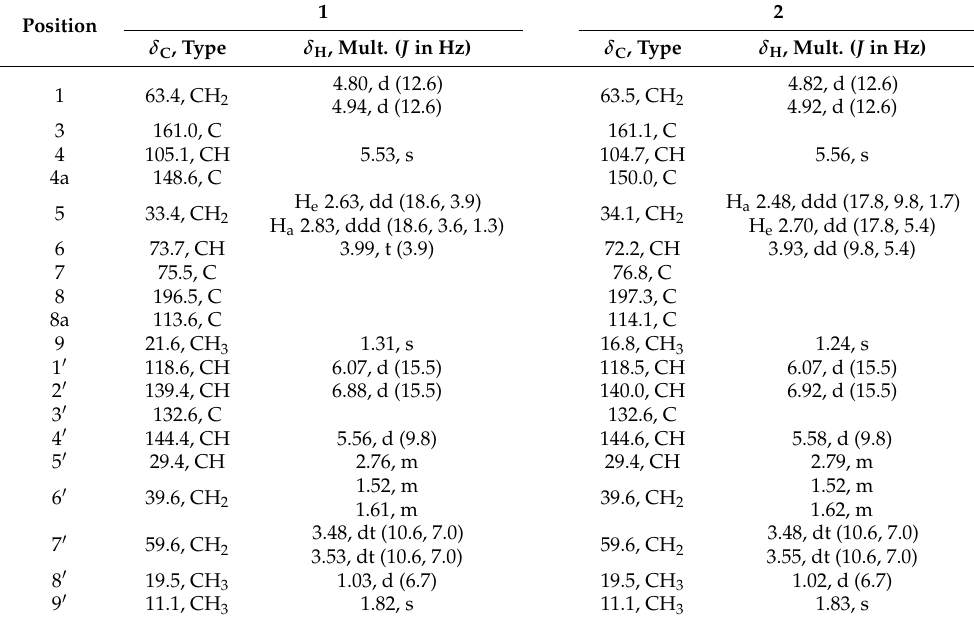
Table 2. 1 H (500 MHz) and 13 C (125 MHz) chemical shifts for identified compounds 1 and 2 in methanol- d 4